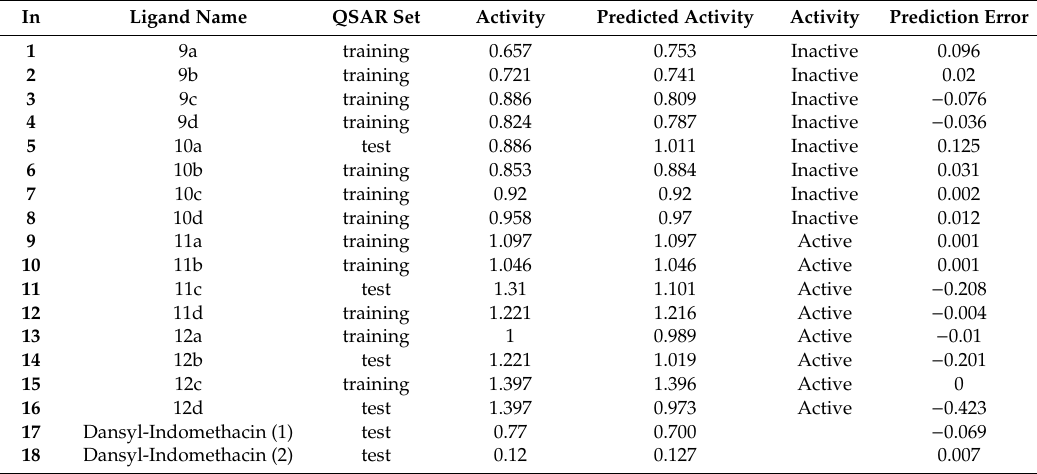
Table 3. Calculated pIC 50 for the designed and the reported